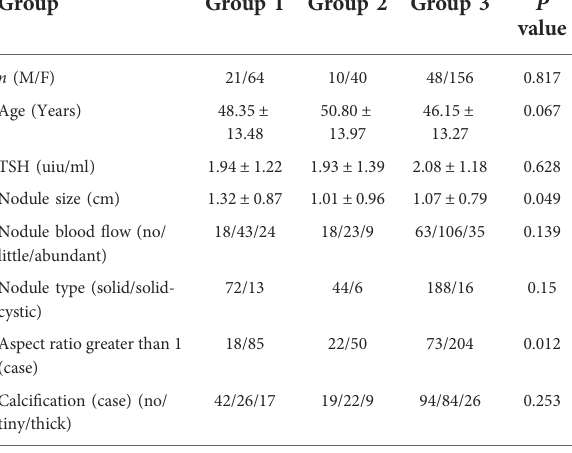
TABLE 2 Comparison between the two groups in terms of general clinical conditions and thyroid ultrasound features ( x ± s ). Group